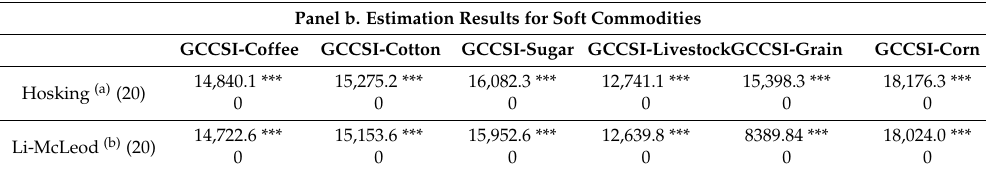
Table 3. The multivariate DCC-GARCH model estimating results. Panel b. Estimation Results for Soft